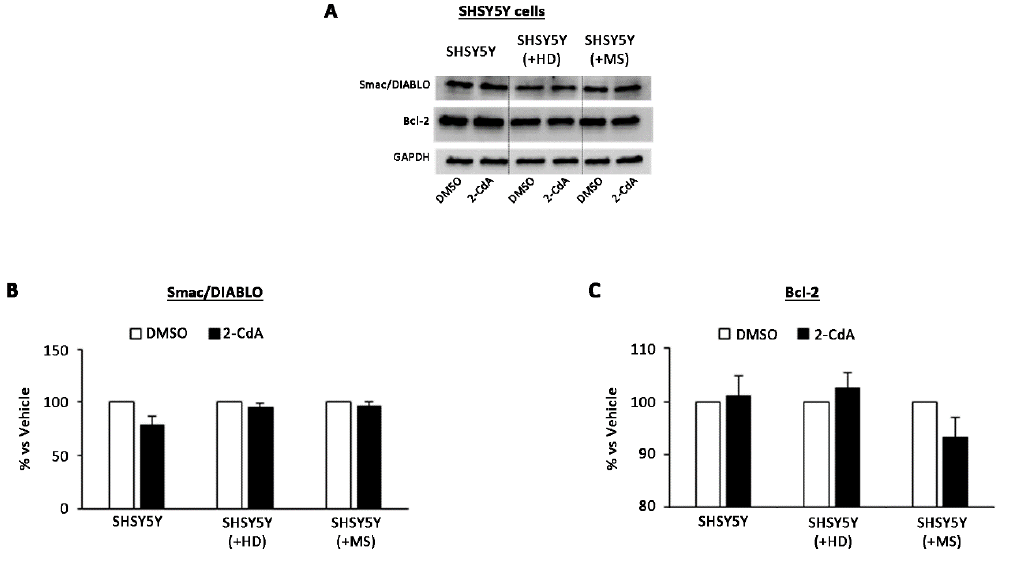
Figure 3. E ff ect of 2-CdA treatment on Smac / DIABLO and Bcl-2 protein expression in SH-SY5Y single-cultured and co-cultured with HD and MS lymphocytes. ( A ) Representative Western blot of Smac / DIABLO and Bcl-2 levels performed on whole cell lysates. Bar graphs show quantification by densitometric analysis of Smac / DIABLO ( B ) and Bcl-2 ( C ) protein band normalized to GAPDH, used as loading control. Values (mean ± SEM of three independent experiments) are expressed as percentage of dimethyl sulfoxide (DMSO). Significance was calculated with Student’s t -test vs.